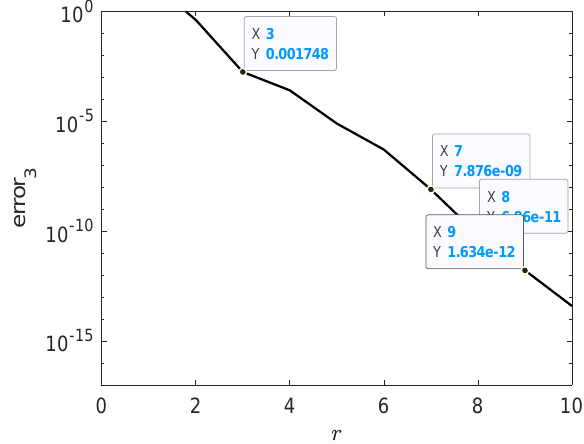
Figure 40. Convergence graph of y 3 .